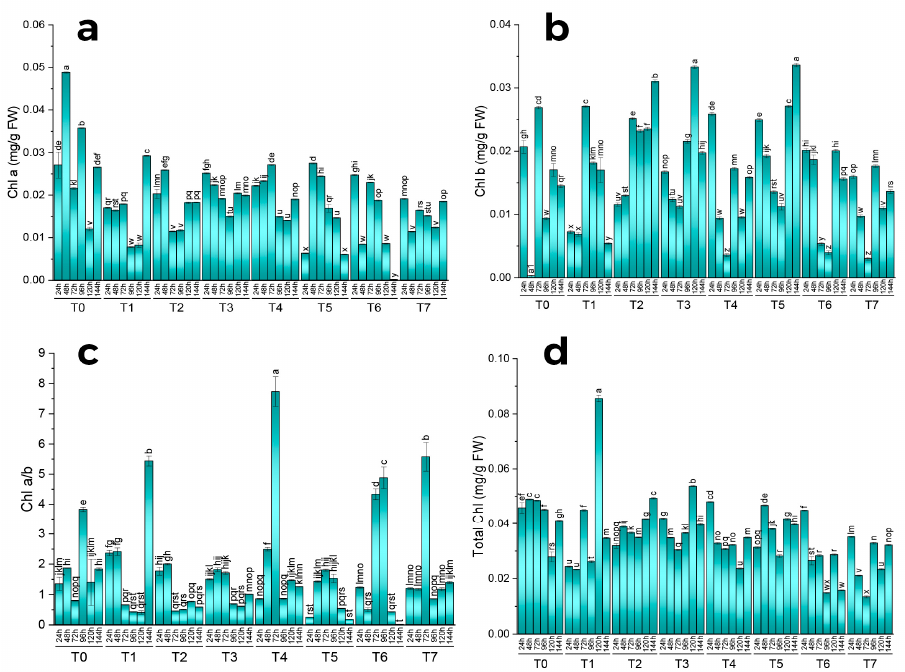
Figure 1. Effect of different treatments of elicitors on chlorophyll a ( a ), b ( b ), and ab ( c ) and total chlorophyll ( d ) contents of Silybum marianum in hydroponics where harvest time on x-axis, first = one day (24 h), second = 48 h, third = 72 h, fourth = 96 h, fifth = 120 h, sixth = 144 h, where (T0 = control, T1 = methyl jasmonate, T2 = silver nanoparticles, T3 = fungal elicitors, T4 = methyl jasmonate + fungal elicitors, T5 = methyl jasmonate + silver nanoparticles, T6 = fungal elicitors + silver nanoparticles, T7 = methyl jasmonate + silver nanoparticles + fungal elicitors); different letters on the bars indicate a difference that was significant at p > 0.05; Tukey test.